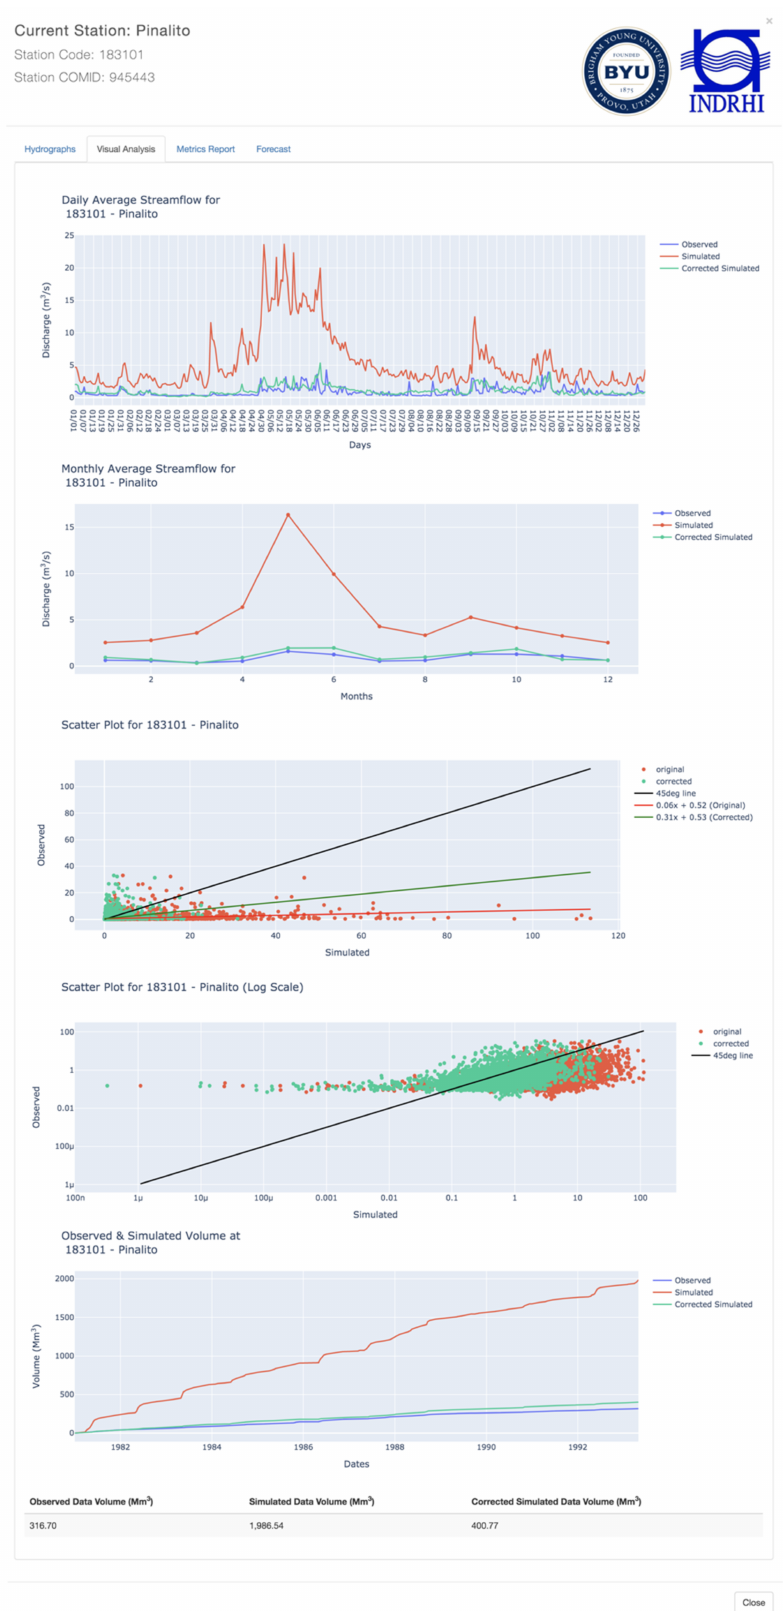
Figure 7. Visual analysis for the Pinalto station in the historical validation tool app for the Dominican